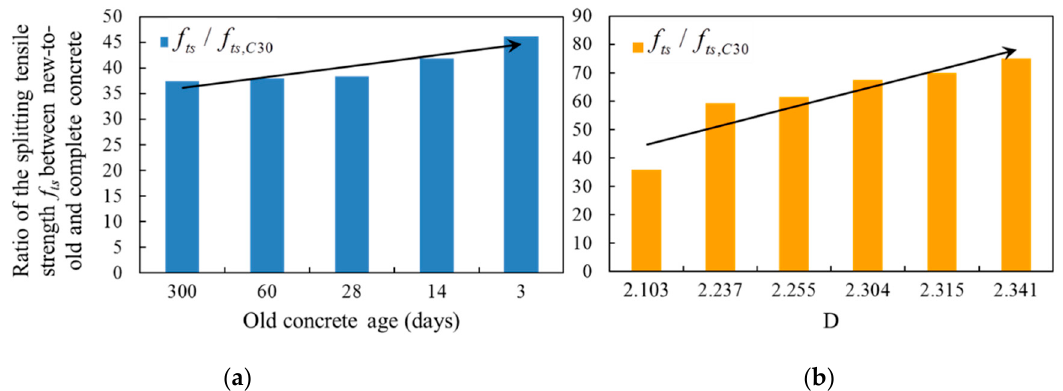
Figure 7. Comparison of influence of roughness and old concrete age on the splitting tensile strength. ( a ) The effect of age; ( b ) The effect of roughness.